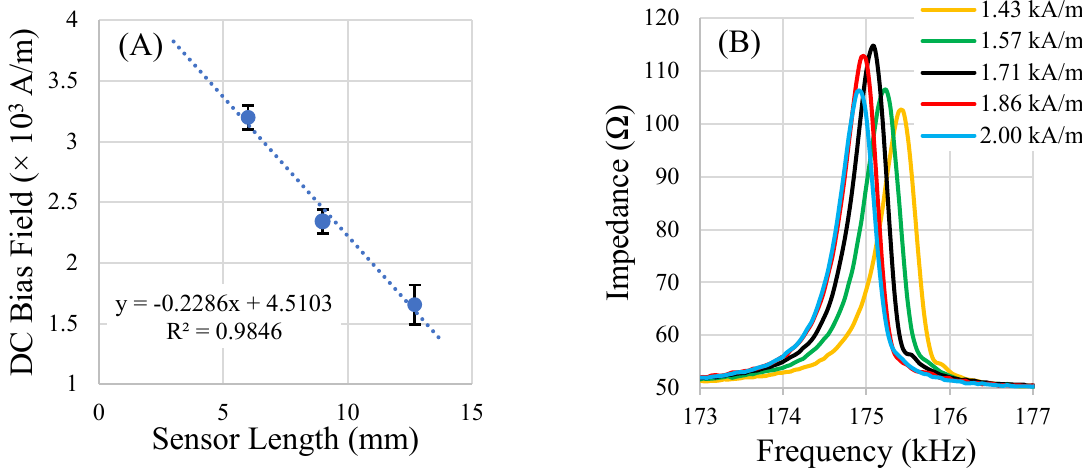
Figure 10. A plot of the results of the DC bias field optimization experiment ( A ) and an example of the under- and over-biasing effects on the resonance spectrum (optimal bias at 1.71 kA/m) ( B ). The sensors were all fabricated at an aspect ratio of 2.5 length over width. ( n = 5; error = ± standard deviation) .